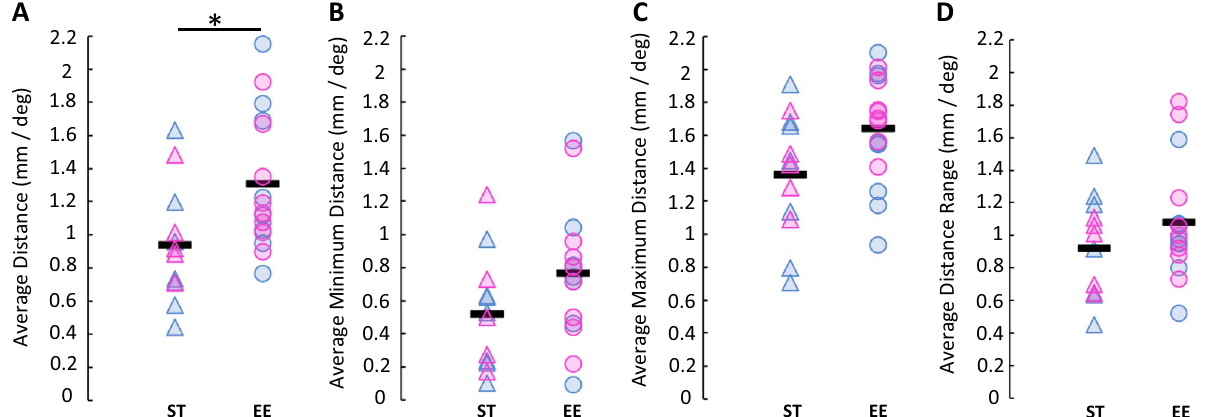
Figure 5. Cortical magnification in standard mice and mice reared in an enriched environment in V1. ( A ) Average distance covered by neighboring pixels in both groups, p = 0.0080 (one-tailed Welch’s t-test). *p < 0.0125. ( B ) Average minimum distance covered by neighboring pixels in both groups, p = 0.0452 (one-tailed Welch’s t-test). ( C ) Average maximum distance covered by neighboring pixels in both groups, p = 0.0253 (one-tailed Welch’s t-test). ( D ) Average distance range covered by neighboring pixels in both groups, p = 0.1106 (one- tailed Welch’s t-test). Individual data points represent individual animals. Pink triangle: ST female (n = 5); blue triangle: ST male (n = 7); pink circle: EE female (n = 8); blue circle: EE male (n = 8). Black line represents the average.